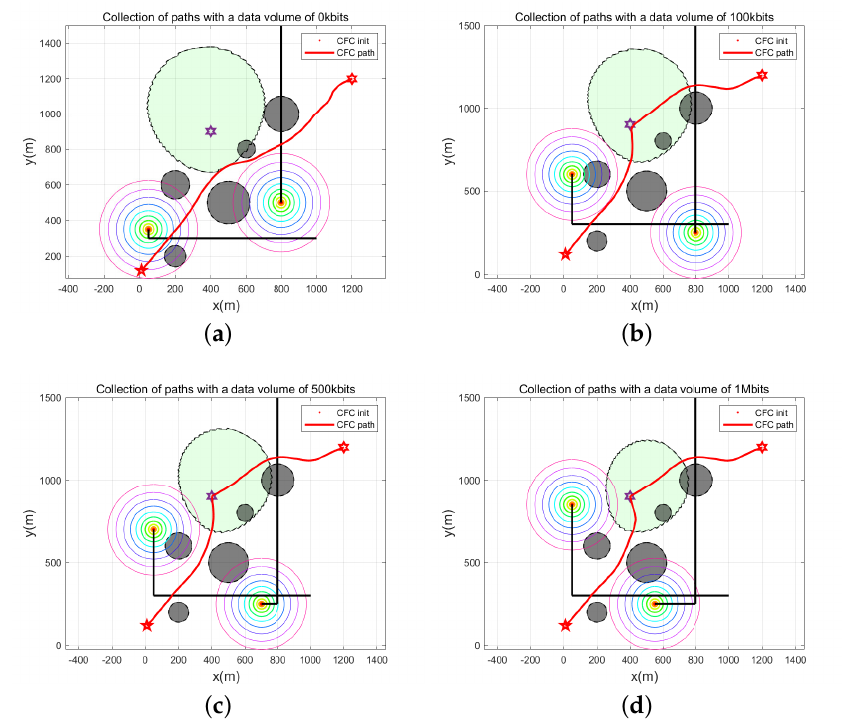
Figure 9. UAV paths for different data collection volumes: ( a ) 0 bits; ( b ) 100 kbits; ( c ) 500 kbits; ( d ) 1 Mbits.